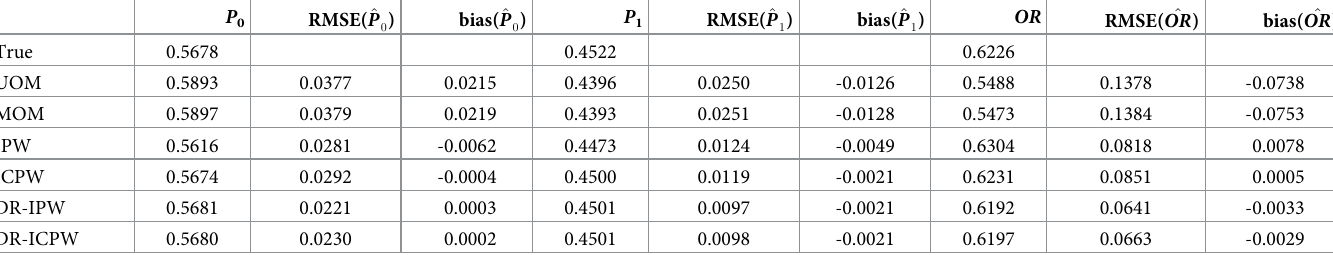
Table 11. Result of the doubly robust sensitivity analysis under outcome model